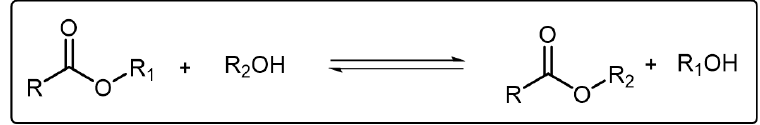
Scheme 5. The representative reaction formula of transesterification.